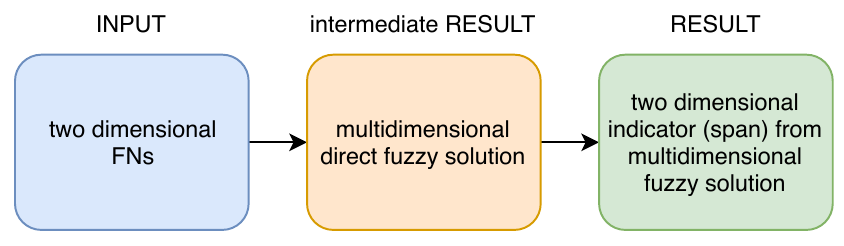
Figure 3. A proposed multidimensional fuzzy (MF)-arithmetic approach